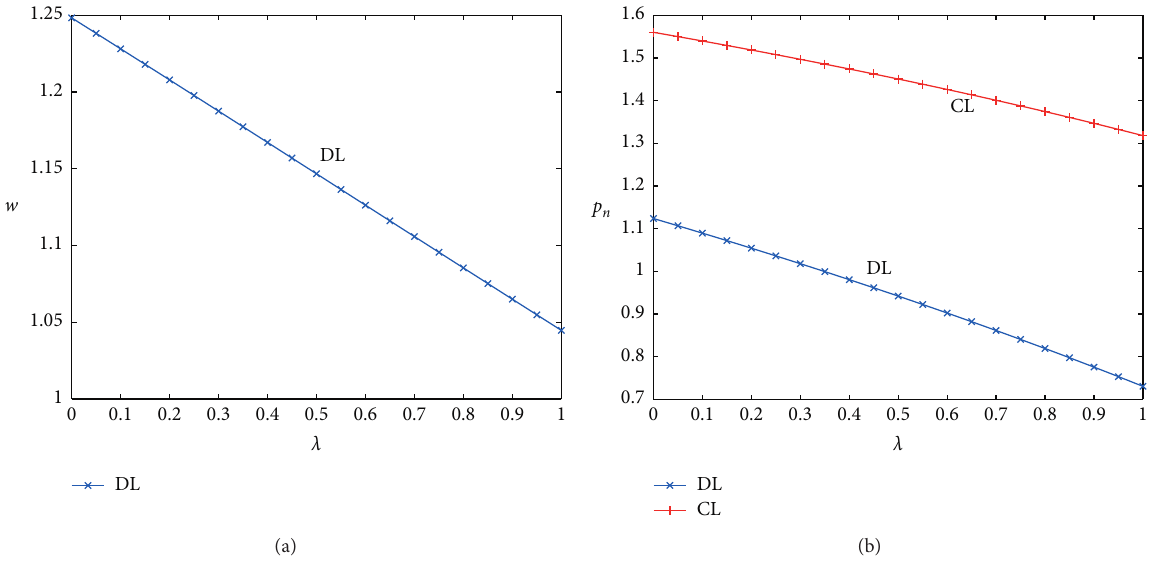
Figure 1: The impact of regret sensitivity coefficient on wholesale price and retail price: (a) wholesale price and (b) retail prices.